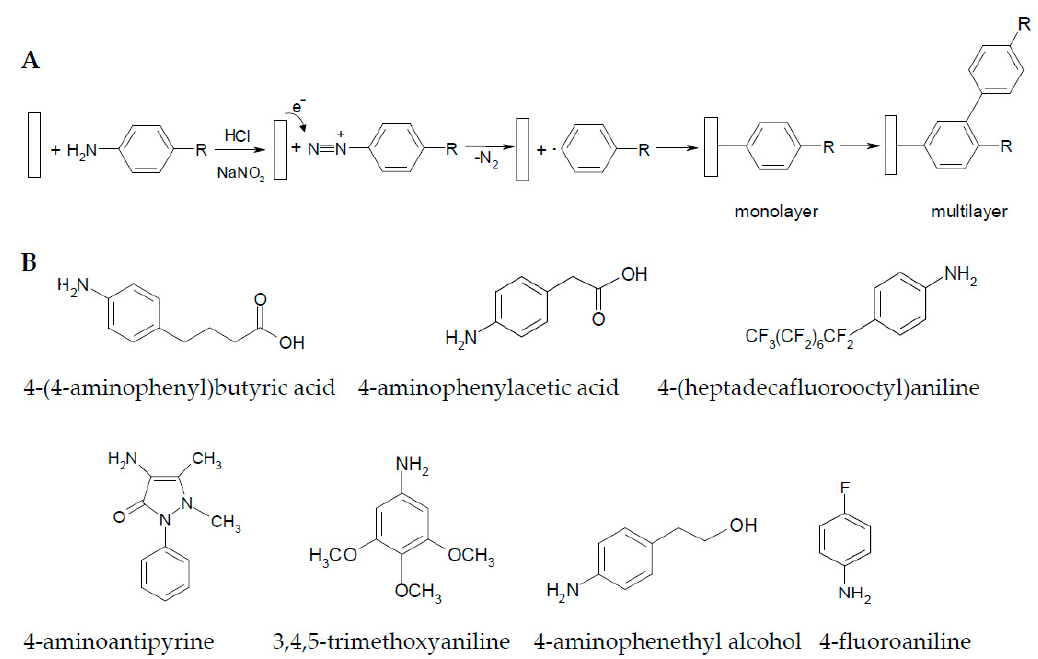
Figure 1. ( A ) Scheme of the electrodeposition reaction used for protective layer formation on copper surface; ( B ) structure of the studied corrosion inhibitors. Amino moieties are removed during the electrodeposition process.